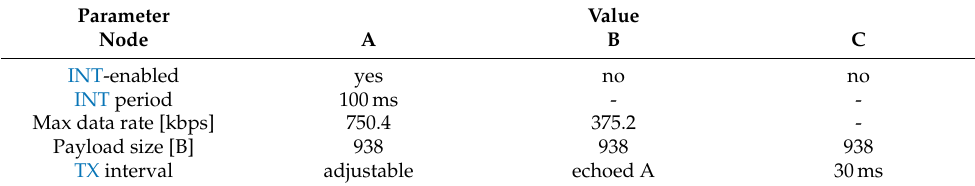
Table 5. Default parameters used in network-aware UDP application